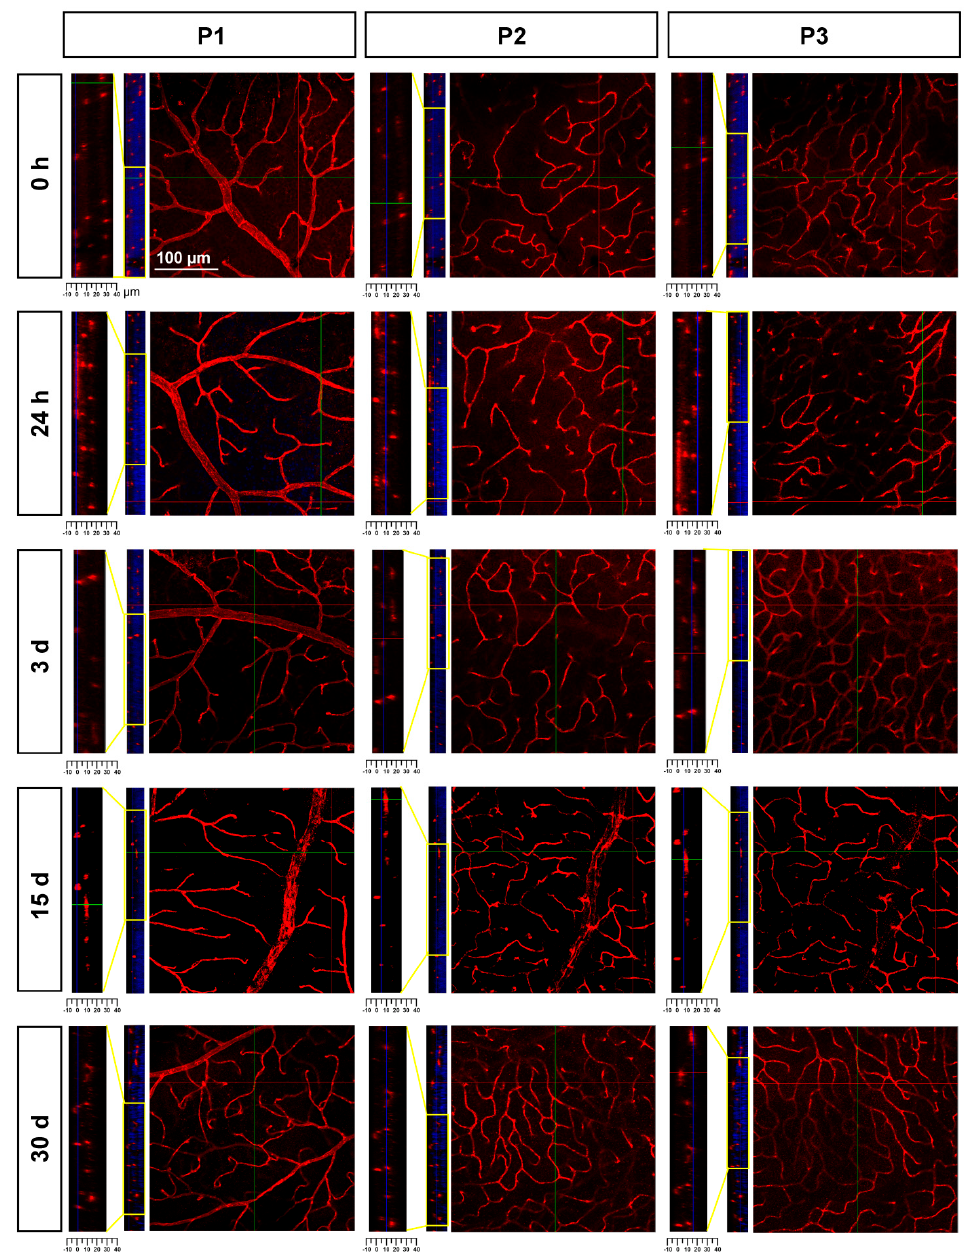
Figure 6. Retinal thinning after ischemia. Confocal images showing Ly6c signal in the three plexuses from 0 h to 30 days after the induction of the ischemia. To the left of each magnification is shown the z-stack spanning the retinal thickness (DAPI in blue) and a magnification of the z-stack (yellow square) where the ganglion cell layer is positioned a 0 µm in all images.